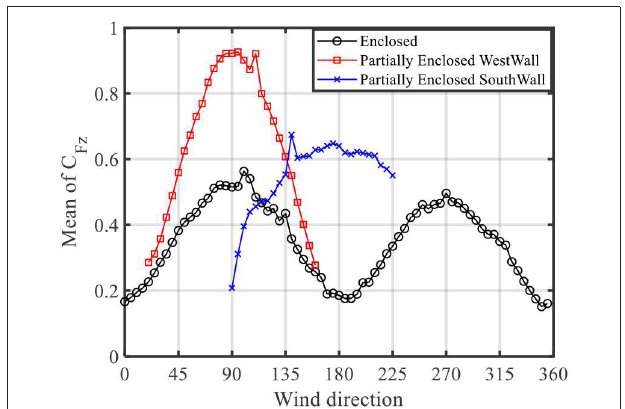
FIGURE 13 | Effect of openings on mean of total uplift force coefficients.